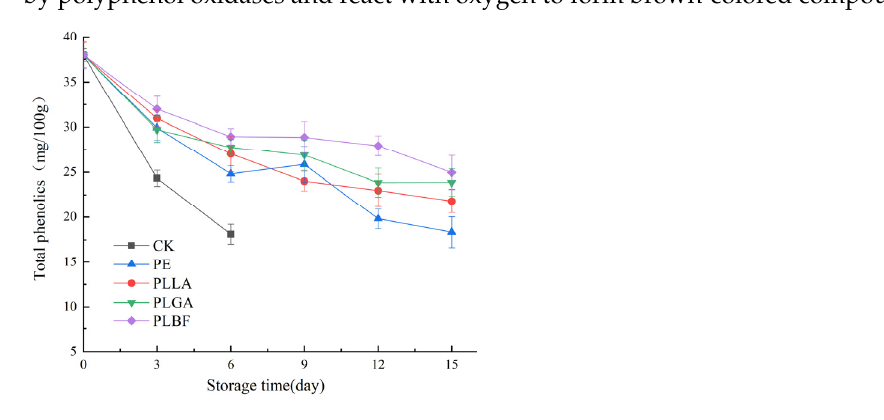
Figure 7. Changes of total phenolic content of Agaricus bisporus in each packaging group during storage.